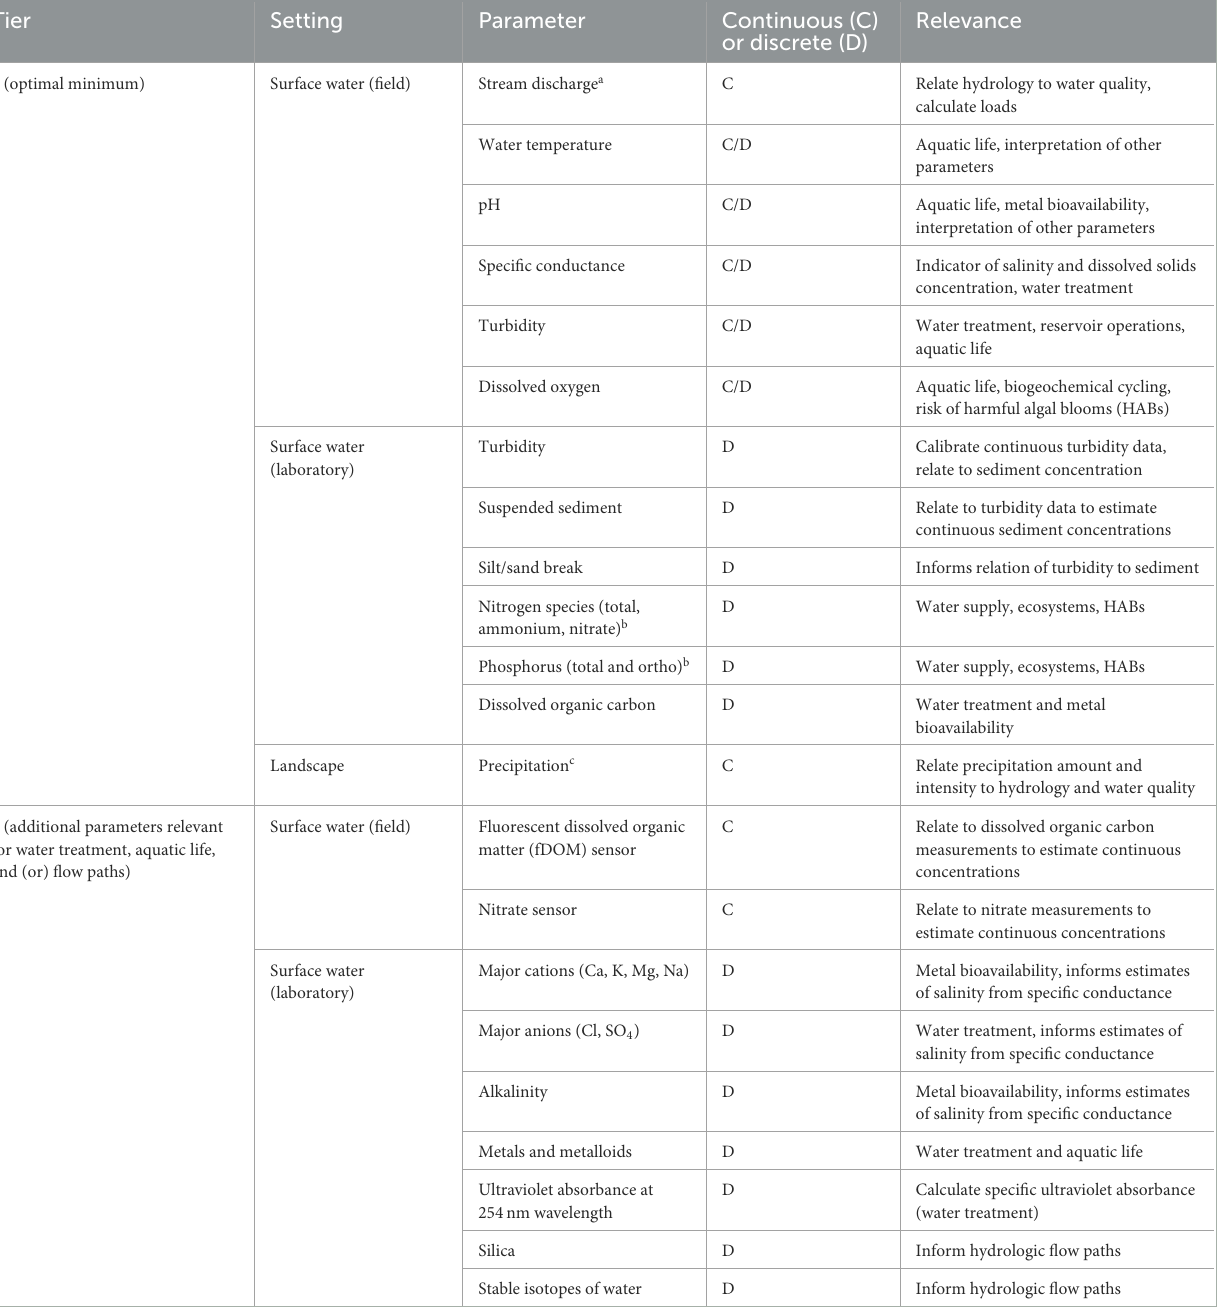
TABLE 1 Critical parameters to measure after wildfire to improve assessment and prediction of water quality.